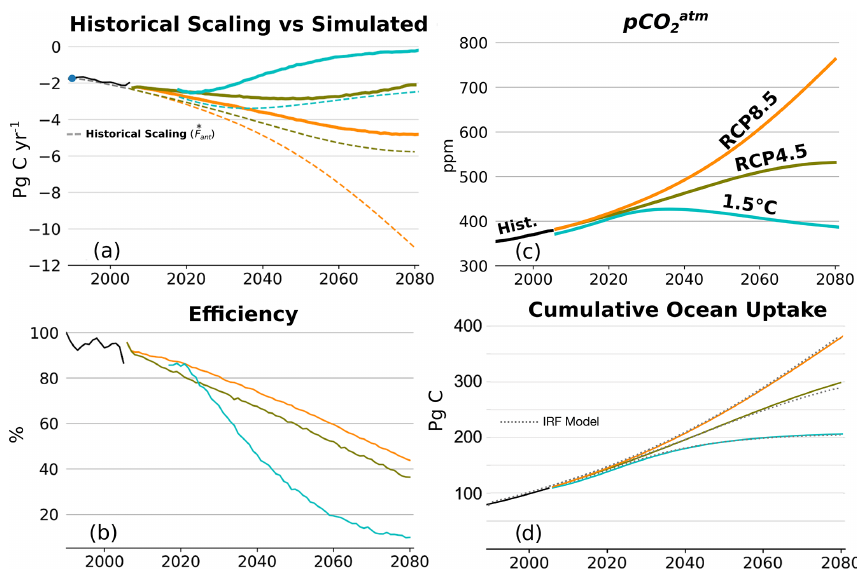
∗ F ant ; dotted lines) and CESM anthropogenic carbon uptake ( F ant ; Figure 2. (a) Historical scaling of ocean anthropogenic carbon uptake ( solid lines) for three scenarios (1.5 ◦ C, RCP4.5, and RCP8.5). Negative indicates atmospheric anthropogenic carbon removal. (b) Efficiency of the global ocean sink for the three scenarios from CESM (Eq. 5). (c) p CO atm for both CESM and IRF model. (d) Total anthropogenic 2 carbon accumulation in CESM (solid lines) and in the IRF model (dotted lines). Flux and efficiency from 2006–2017 are not shown for the 1.5 ◦ C scenario due to ocean adjustment to p CO atm forcing (see Sect. 2.2; Fig. 2